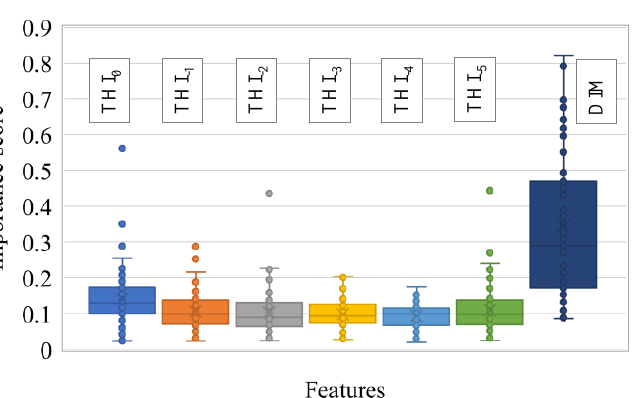
Figure 8. Boxplot diagram of the importance score of the different features for the whole dataset in scenario A. Table 1. Minimum value, maximum value, median value, standard deviation value, and coefficient of variation (CoV) value of the ISs obtained for the different independent variables calculated for the whole dataset in scenario A.